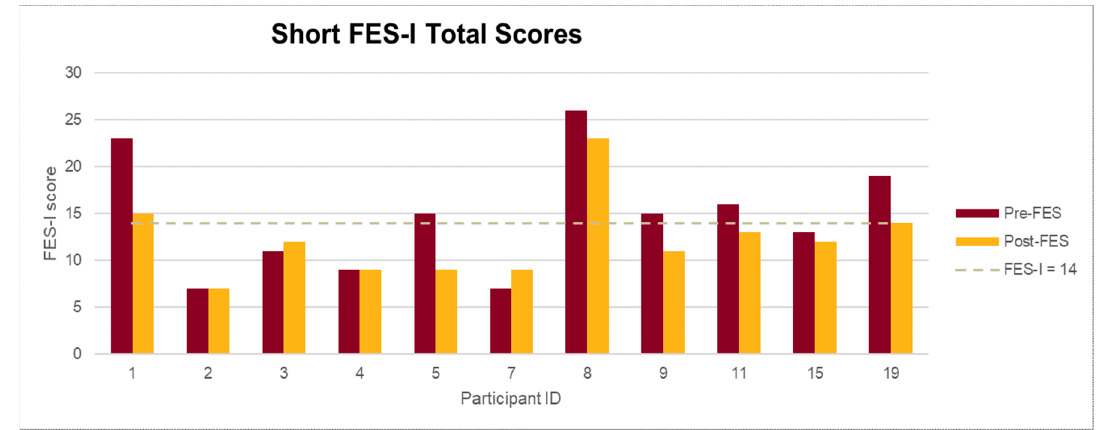
Figure 1. Falls Efficacy Scale-International (FES-I) score indicates level of concern of falling: Low: 7–8; Moderate: 9–13; High: 14–28. n = 11. FES-I plausible range 7–28, higher scores indicate higher concern. A mean decrease of 5 s (relative change of 21%) in mean TUG time (95% CI: ( −